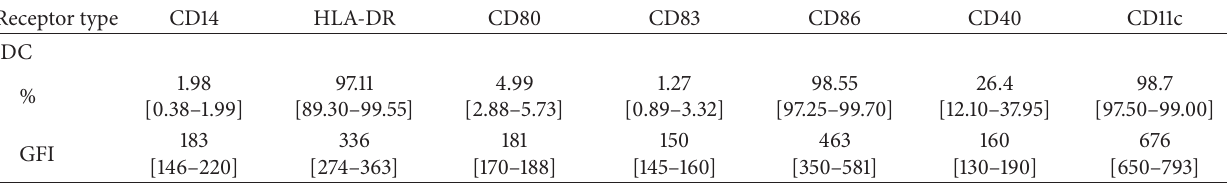
Table 2: Expression of chosen receptors (CD14, HLA-DR, CD80, CD83, CD86, CD40, and CD11c) on monocyte-derived DCs surface. Receptor